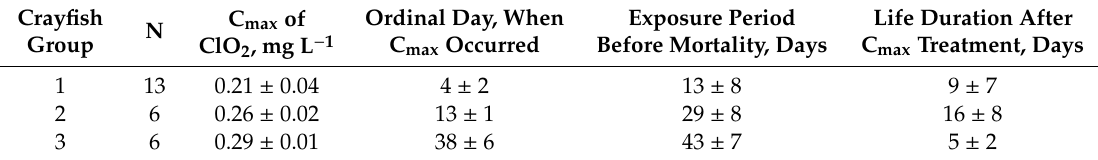
Table 1. Crayfish division based on the day of exposure to maximum concentration of ClO 2 (C max ); life duration after C max treatment over the entire exposure period; and N—Number of crayfish in each group. Data presented as means ±